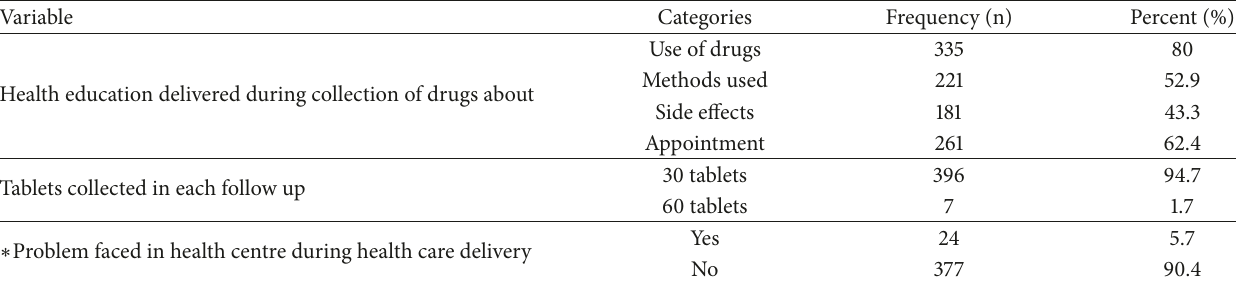
Table 4: Health service-related factors of respondents, Lay Armachiho district health centers, Northwest, Ethiopia, 2017 (n=418).